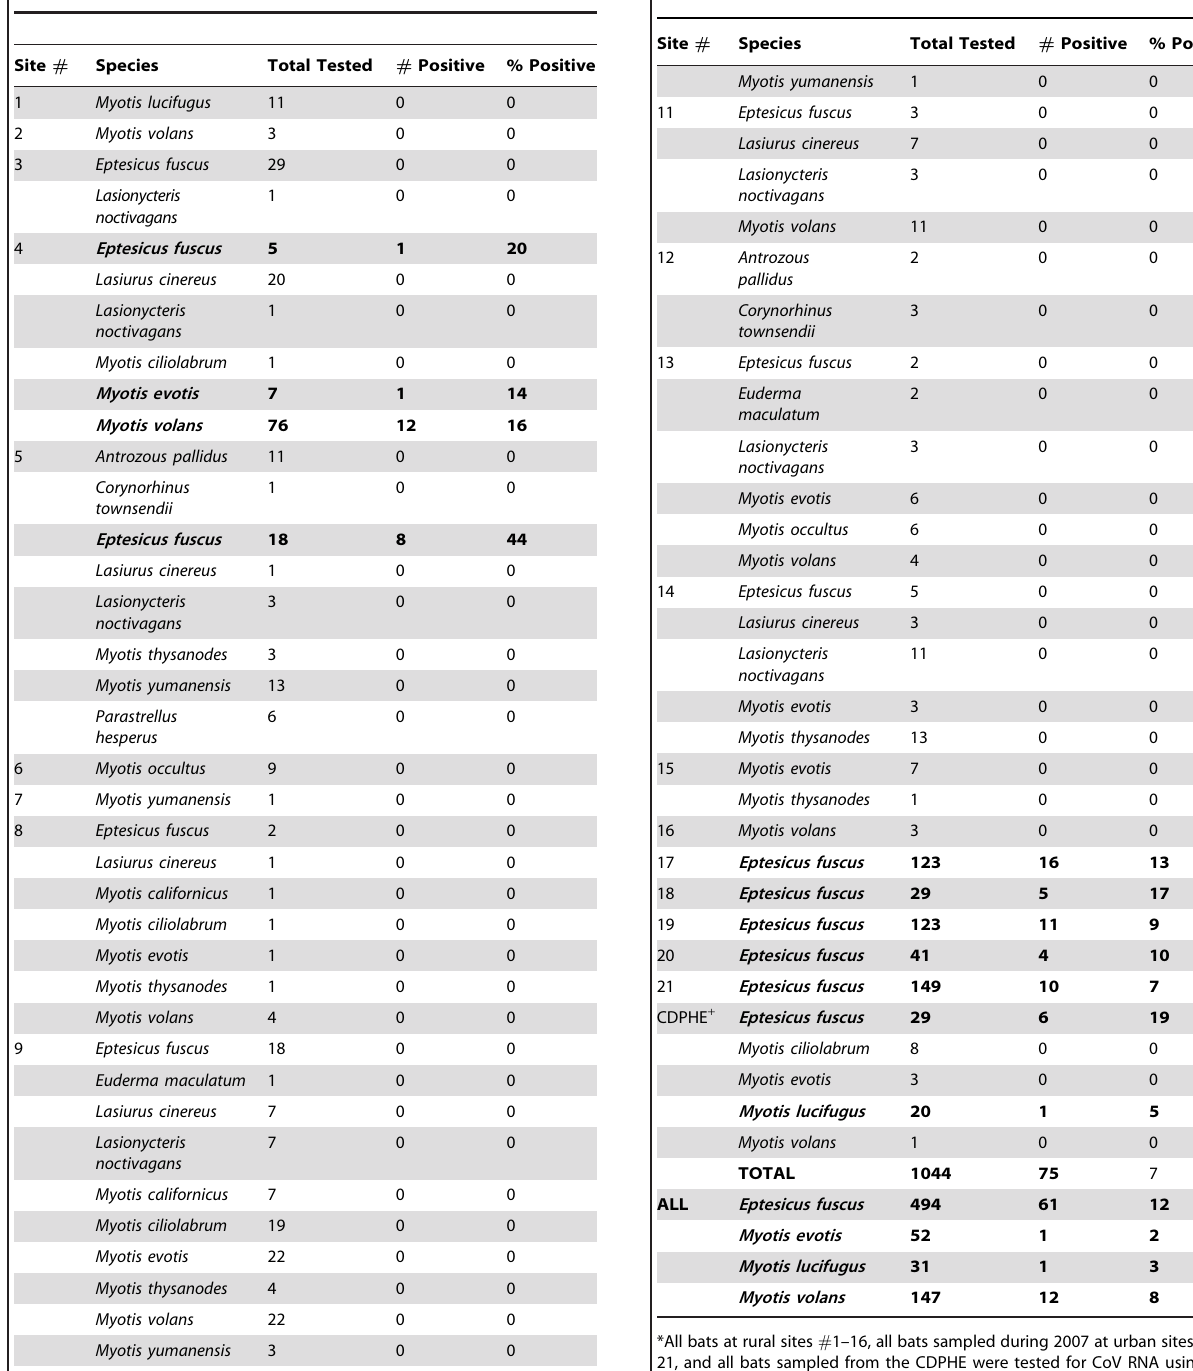
Table 1. Prevalence of bats of various species that were positive * for CoV RNA at different